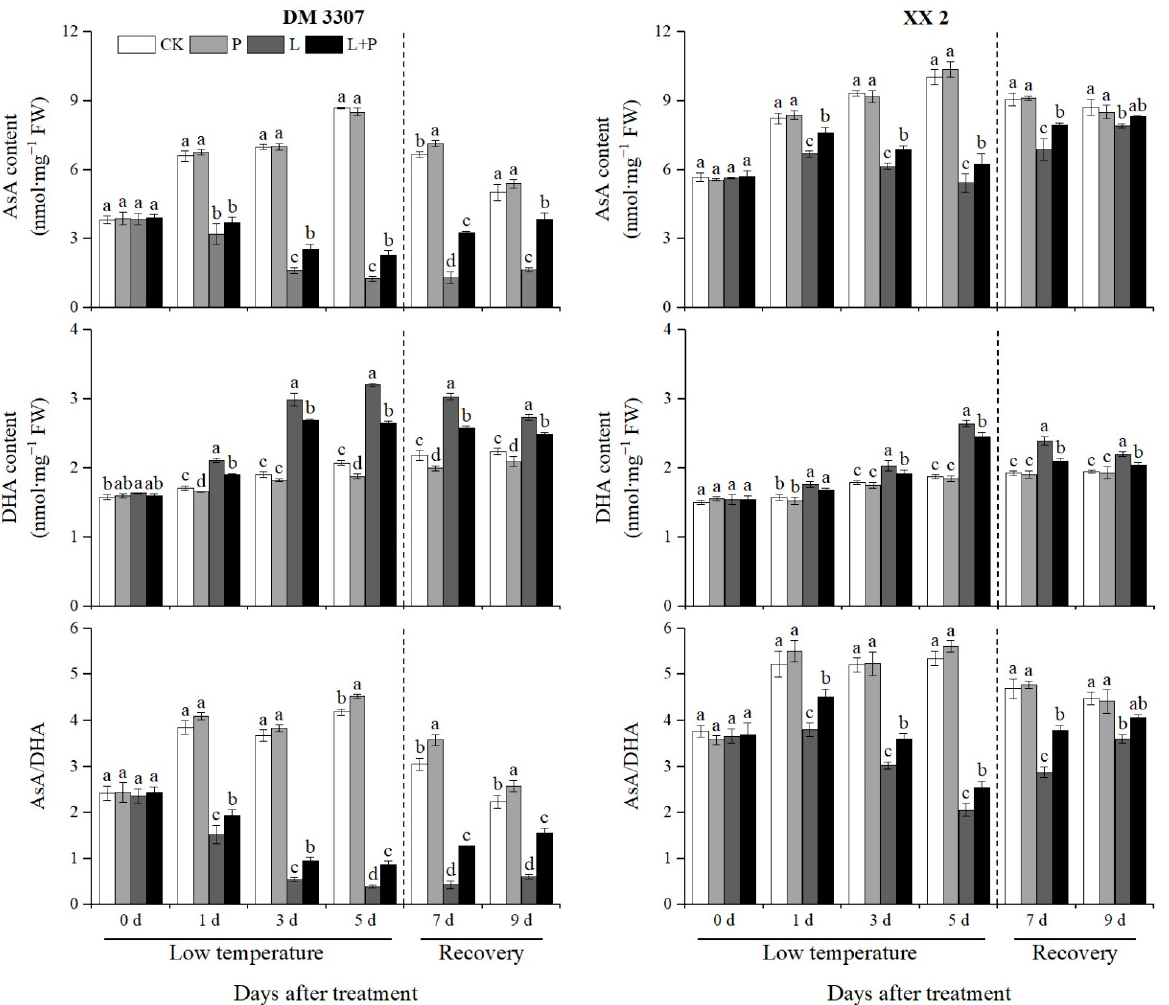
Figure 4. Effect of exogenous proline on the contents of AsA, DHA and AsA/DHA ratio in embryos of maize under the different treatment conditions. Notes: Data are expressed as mean ± standard deviation. Different letters within the same column indicate significant differences at the 5% level. CK: control group; P: proline treatment; L: low-temperature stress treatment; L + P: low-temperature stress + proline combined treatment. Different small letters represent significant differences between treatments ( p <